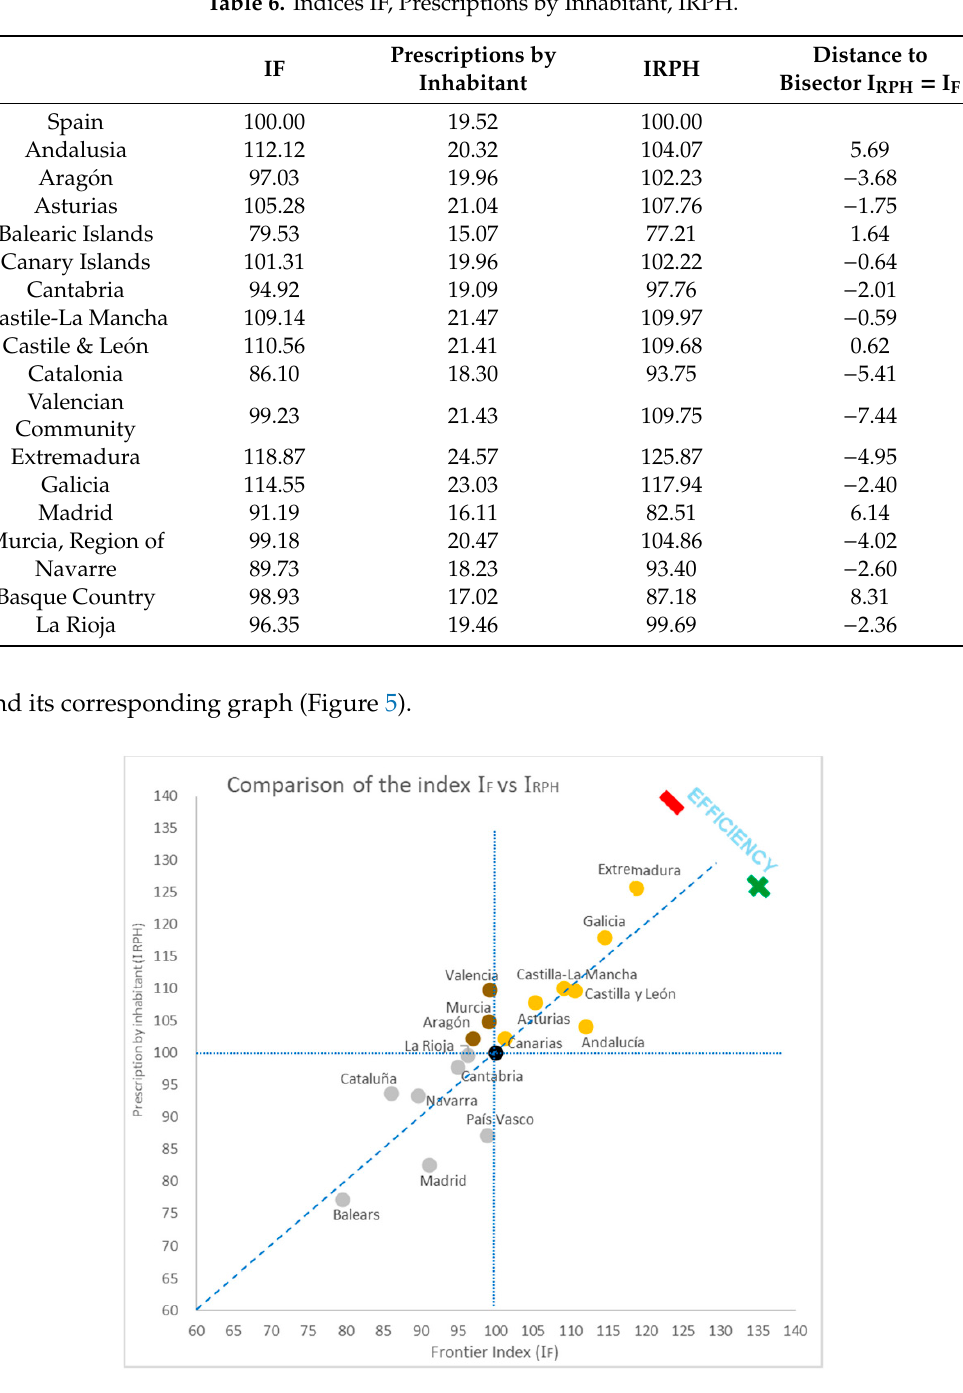
Figure 5. Comparison of the index IF vs. IRPH.